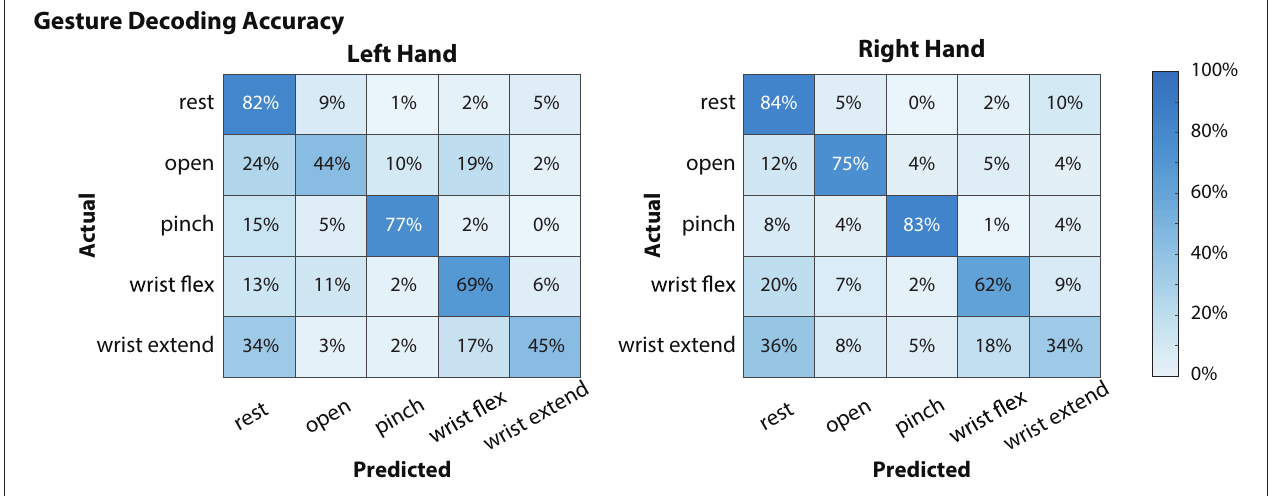
FIGURE 3 | Offline decoding performance for the left and right hands during simultaneous attempted gestures (including “rest”). Contralateral neural signals were used to decode each hand (i.e., left motor and somatosensory cortex signals were used to decode right hand movements). On each hand, there were 48 instances for each of the movement classes (open, pinch, wrist flex, wrist extend) and 64 for the “rest” condition. Of the movements, “pinch” gestures were decoded with the highest accuracy for both left and right hands, while “wrist extend” was notably more difficult to decode (45 and 34% for left and right hands,